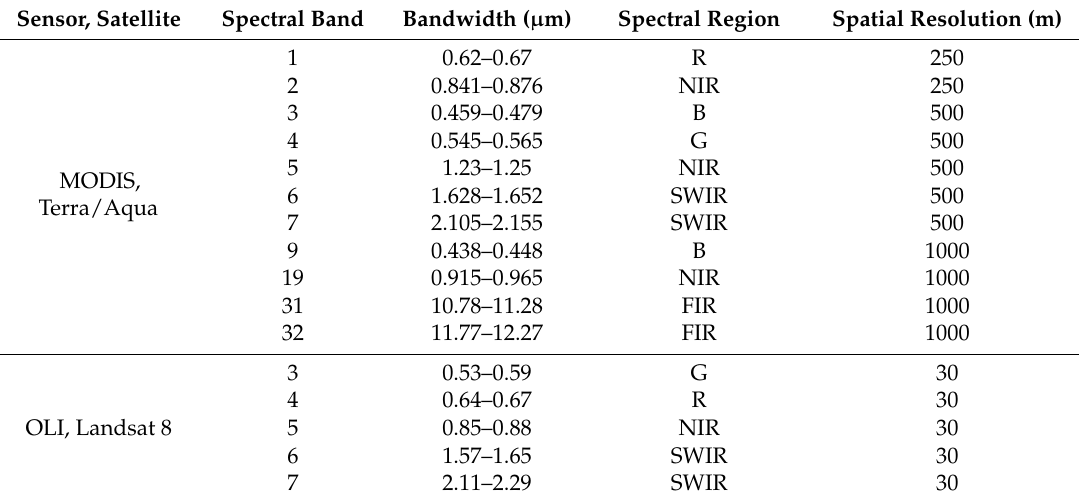
Table 1. The characteristics of the spectral bands used of MODIS and OLI